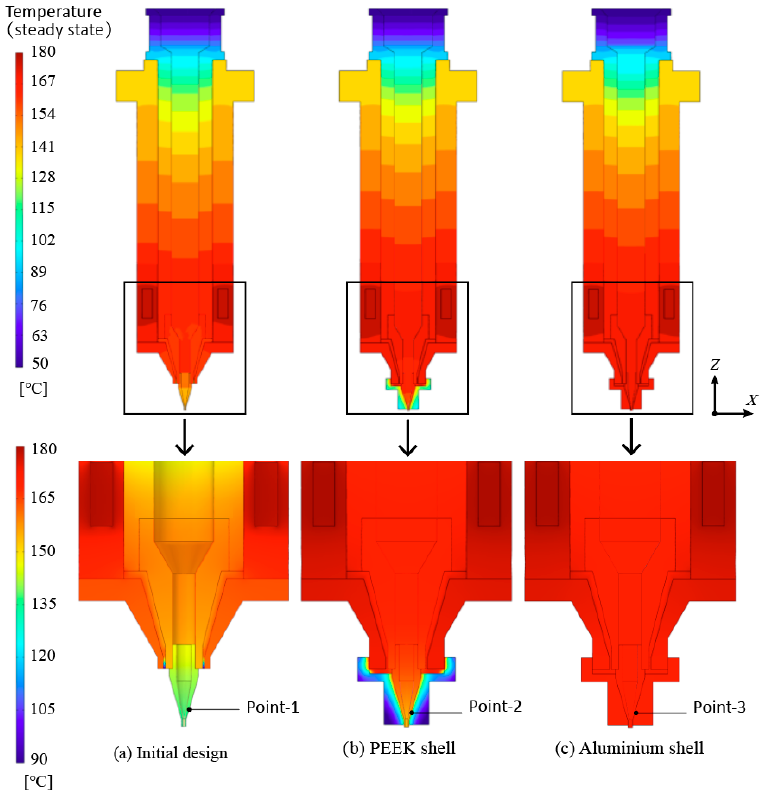
Figure 4. Temperature distributions of the print heads with heat source temperature of 180 °C.